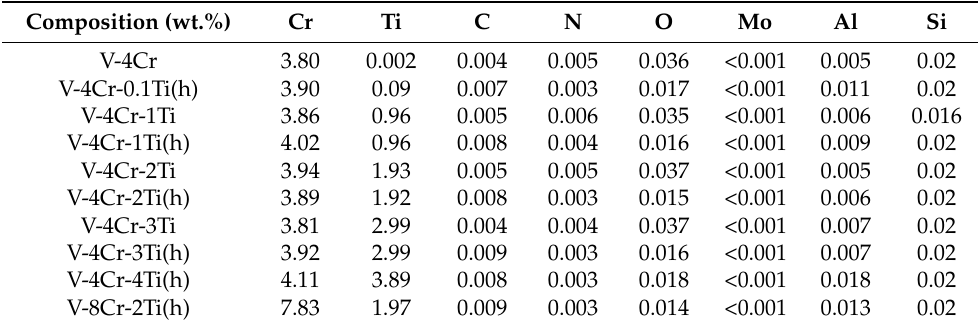
Table 1. Chemical composition of V–Cr–Ti alloys measured by ICP-AES method. An (h) indicates a highly-purified impurity